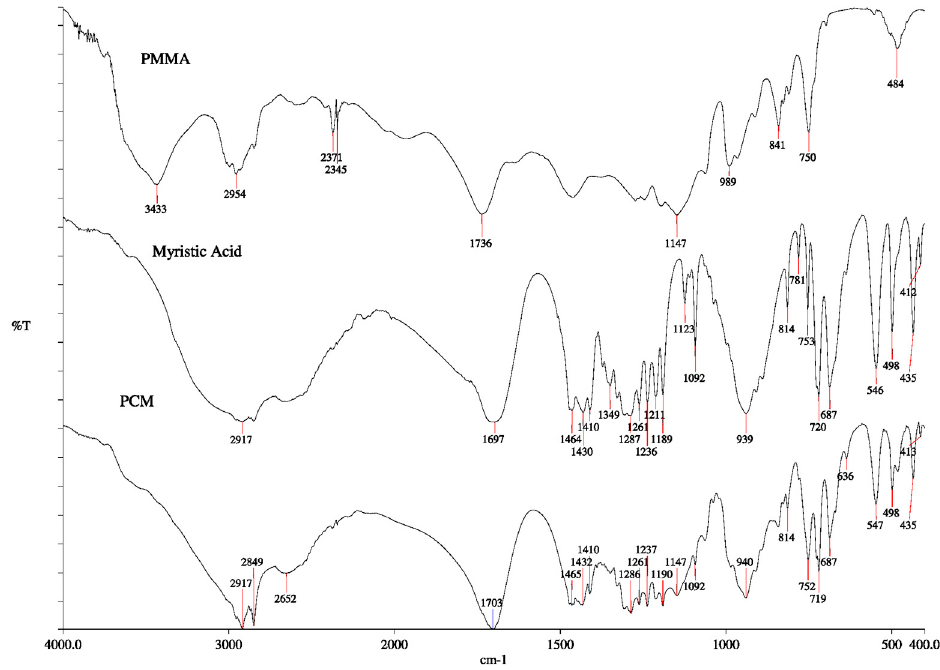
Figure 3. Fourier transformation infrared (FTIR) spectra for the pure polymethyl methacrylate (PMMA), pure myristic acid (MA), and composite phase change material (PCM) (MA/PMMA, 60/40 wt %).